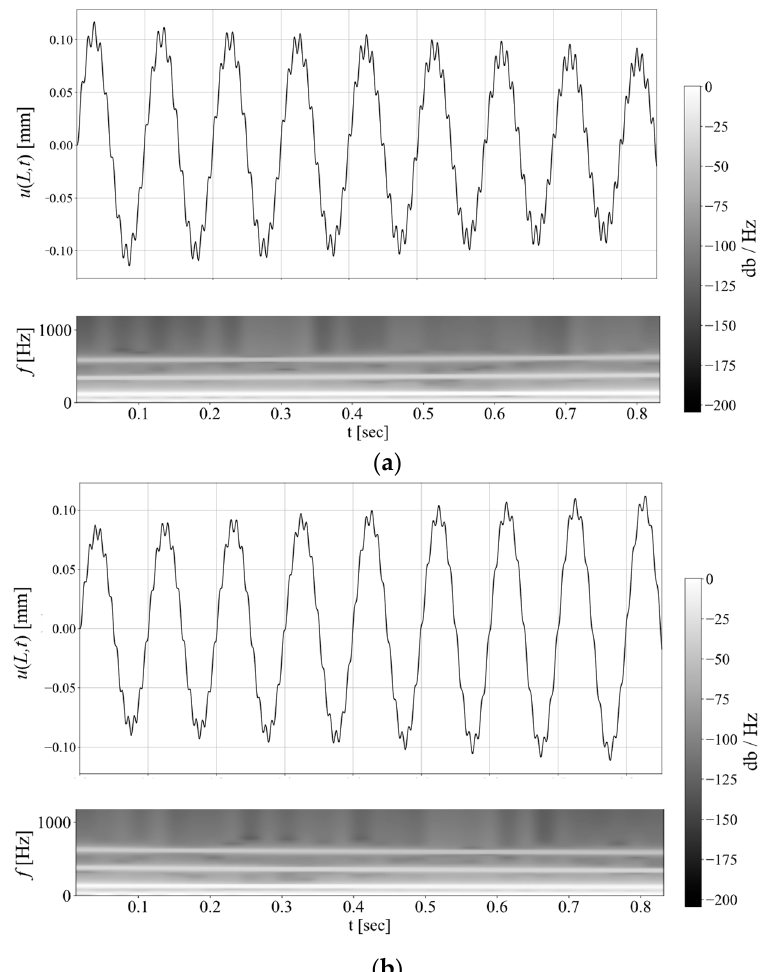
Figure 6. Axial displacement at the top of the pylon for harmonic ground motion 𝑥 (cid:3034) (𝑡) = 𝑥 (cid:3034)(cid:3042) sin (2𝜋 ∙ 10𝑡) and computed spectrogram depicting the time evolution of the first three pylon- mass system eigenfrequencies 𝑓 (cid:3036) (𝑡) : ( a ) Decreasing top mass case ( 𝜇 < 0) ; ( b ) increasing top mass frequencies f i ( t ) : ( a ) Decreasing top mass case ( µ < 0); ( b ) increasing top mass case ( µ > case ( 𝜇 (cid:3408) 0) .